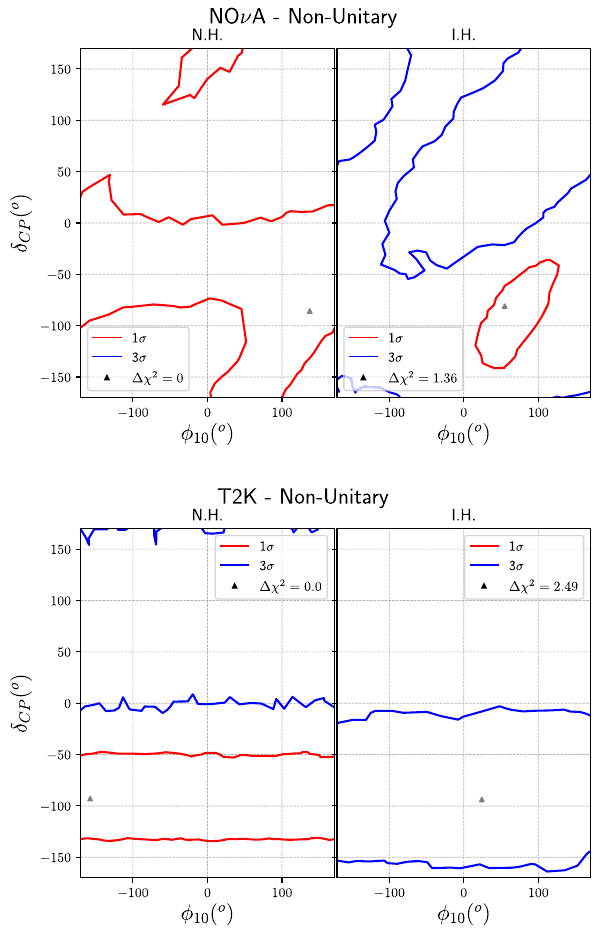
Fig. 13 Allowed regions in the sin 2 θ 23 − δ CP ( δ CP − φ 10 ) plane for the combined analysis in the upper (lower) panel. The left (right) panel is for NH (IH). The red (blue) lines indicate 1 σ (3 σ ) CL. The minimum χ 2 for the unitary (non-unitary) case is 173.40 (170.90). The parameter values atthebest-fitpoint have beenmentionedinTable3. These results are for 2019